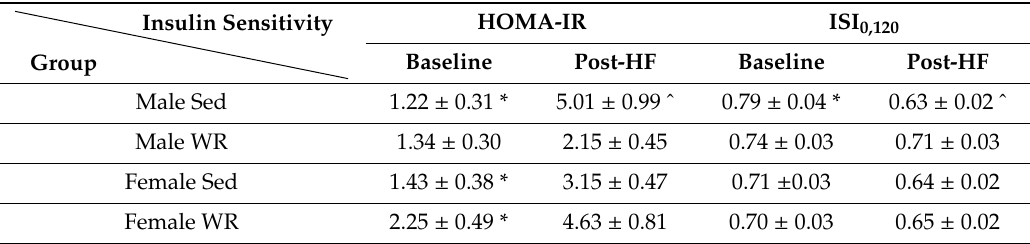
Table2. Hepaticandperipheralindicesofinsulinsensitivity. Exerciseprotectedagainstthedevelopment of insulin resistance by HF diet to a greater extent in males than females.